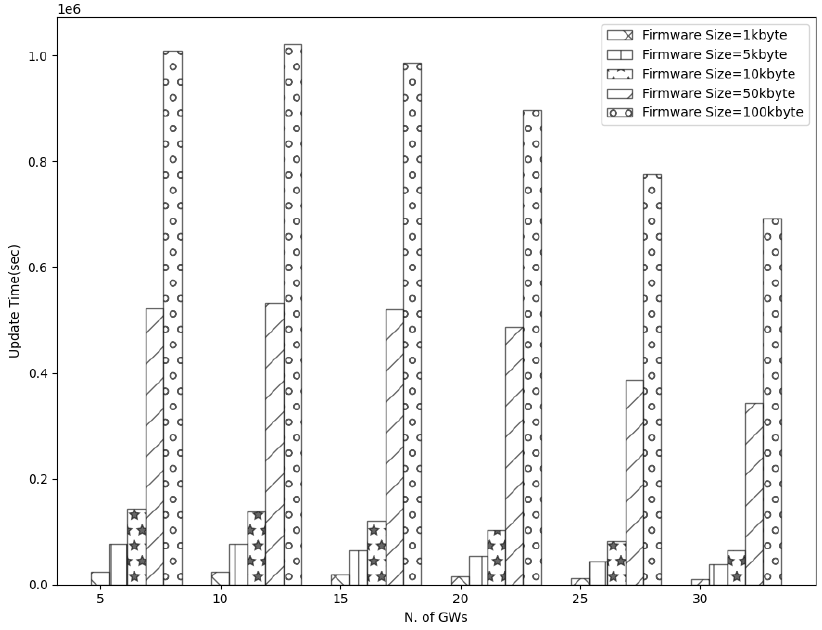
Figure 4. Update time using multiple GWs and firmware size.